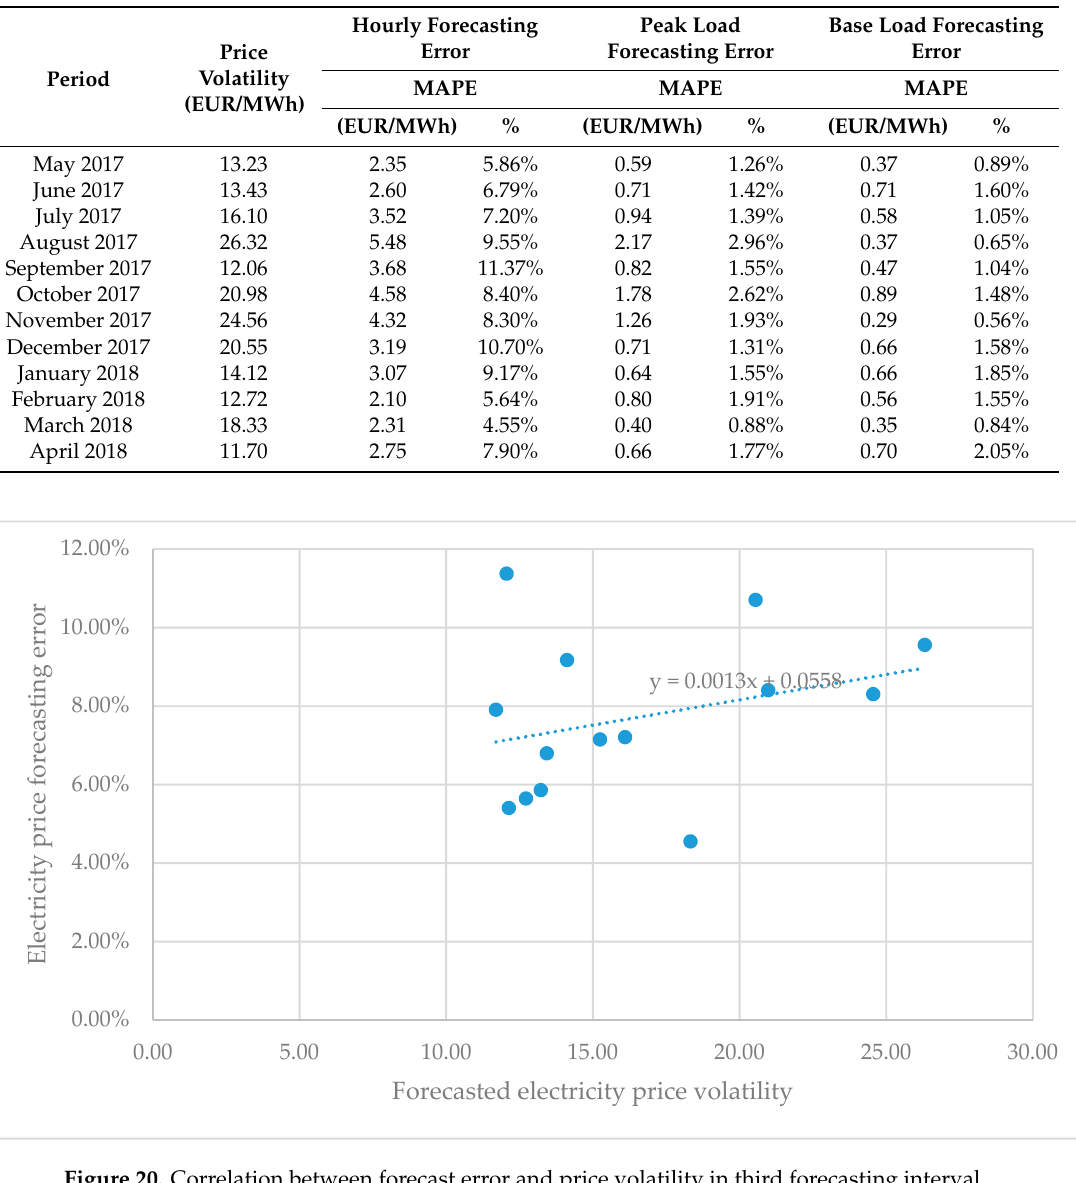
Figure 20. Correlation between forecast error and price volatility in third forecasting interval.